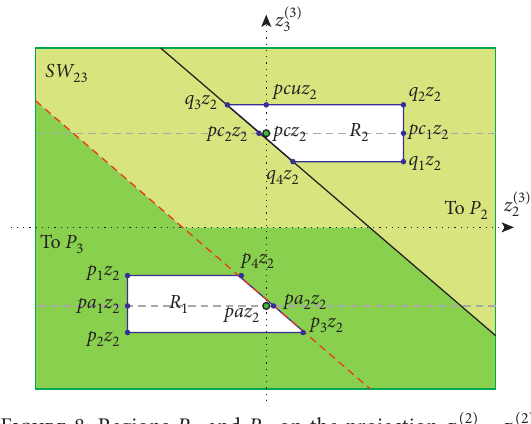
and R on the projection z ( 2 ) 1 2